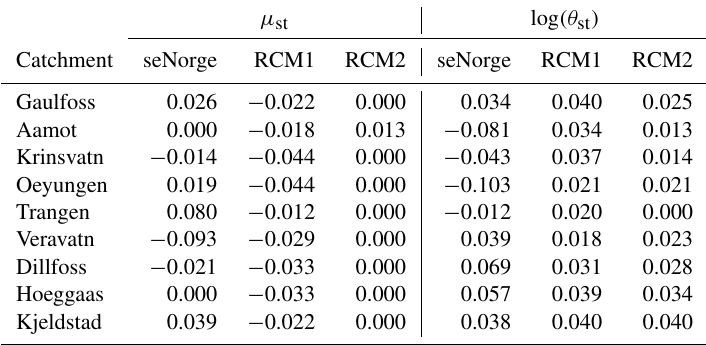
Table 4. Estimated changes in the trend coefficient in Eq. (8) between the training period 1957–1986 and the test period 1987–2005, for µ st in the probit model (left) and log (θ st ) in the gamma model (right). Estimates for three different data sources at 12km resolution are shown: upscaled seNorge data and two RCM outputs. µ